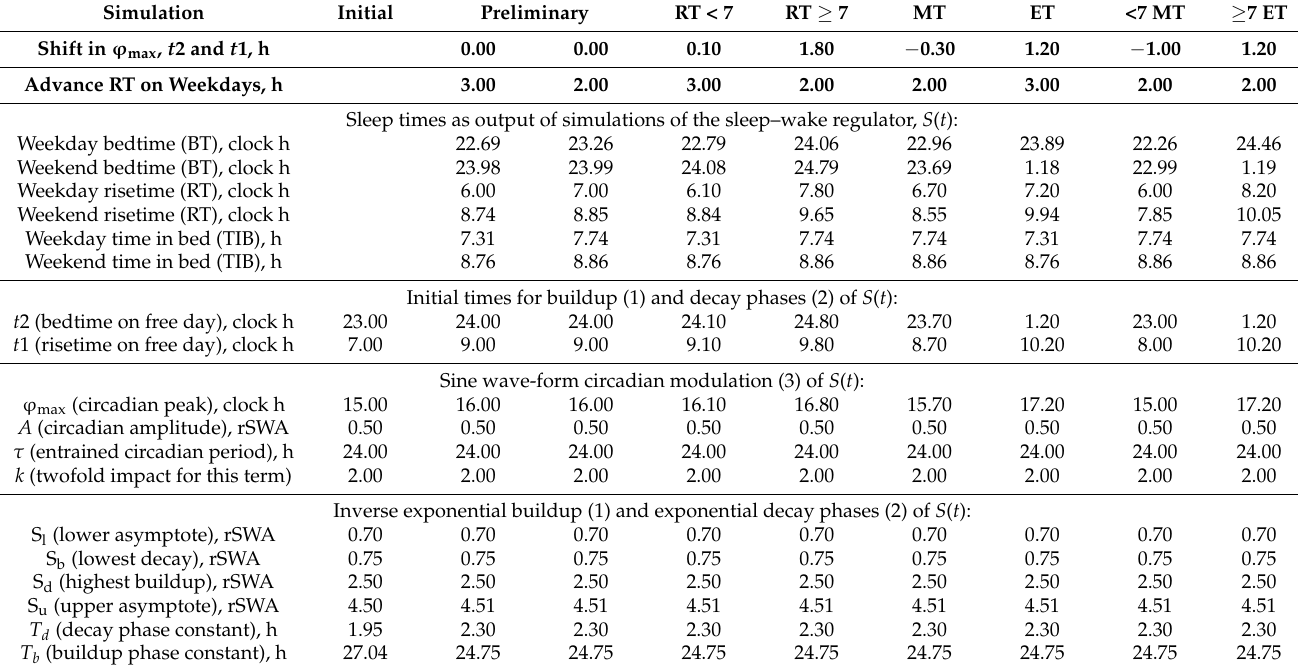
Table 2. Parameters of the model and output of preliminary and final simulations of sleep times.